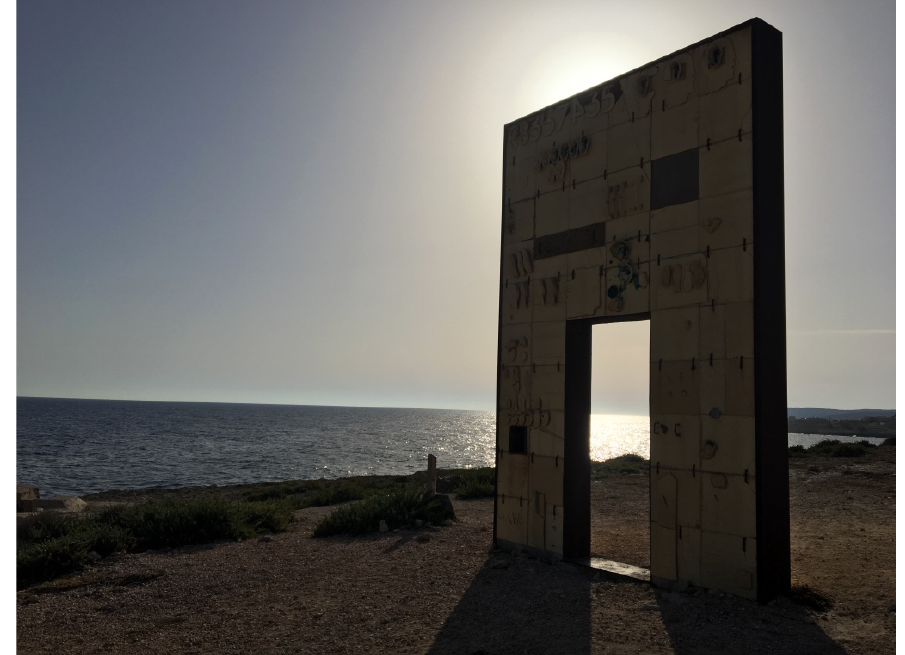
Figure 1. Porta di Lampedusa, Porta d’Europa/Gate of Lampedusa, Gate of Europe, by Mimmo Paladino, 2008. Photo taken by the author in May